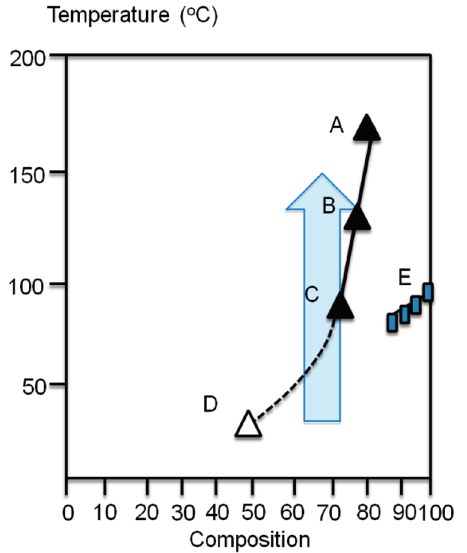
Figure 3. The phase diagram of the P3OT/EVA20